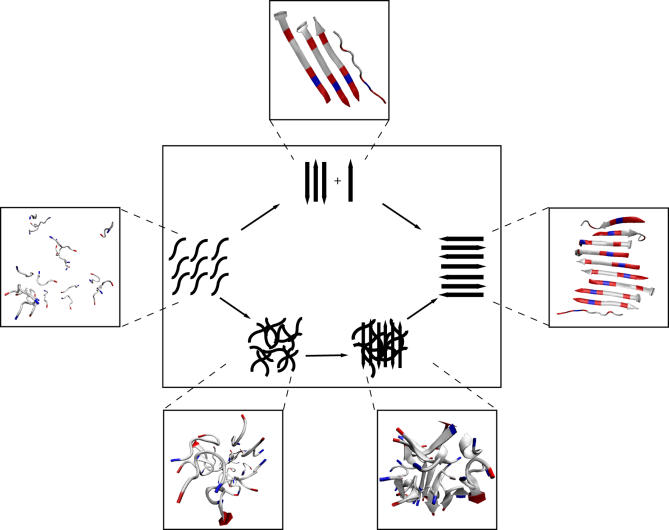
Schematic Diagram of the Two-Step Mechanism of Amyloid FormationSchematic diagram of the mechanistic pathway resulting in the formation of ordered oligomers, described in this study, showing an effective one-step process involving the assembly of monomers directly into β sheet rich oligomers (top) and a more general two-step process, where the monomers coalesce to form molten oligomers before undergoing a process of conformational conversion (bottom). The boxes show representative structures from simulations of Aβ16–22 (lower and left panels) and Aβ25–35 (top and right panels).